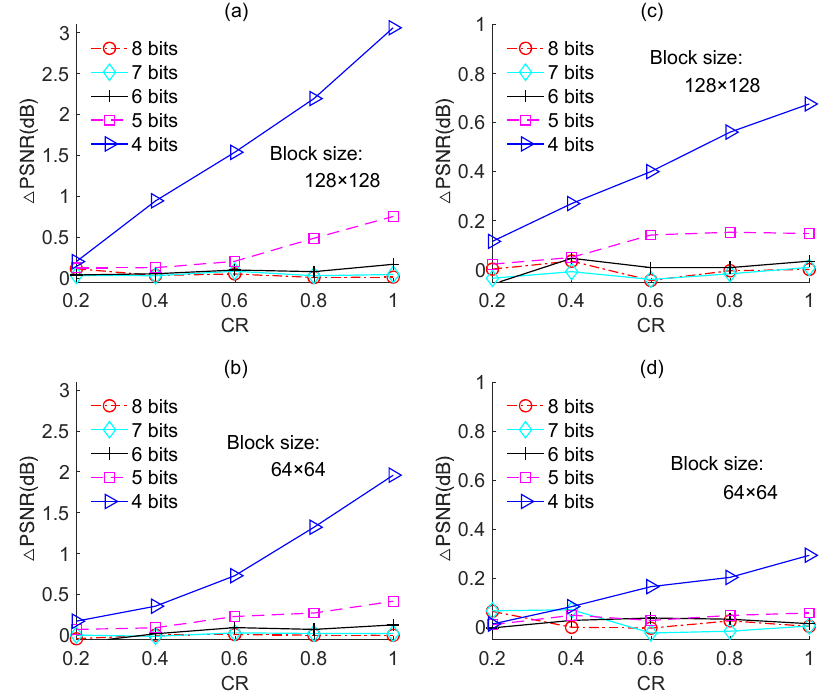
Figure 13. PSNR losses of the quantized BCS with different resolutions of ADC for the “House” image. ( a , b ) are based on Zadoff–Chu measurement matrix; ( c , d ) are based on real-valued Hadamard measurement matrix.